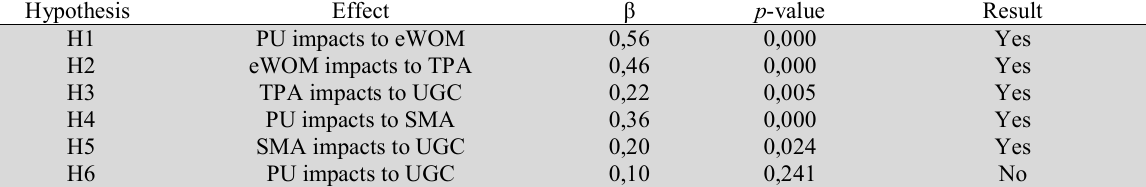
Results of hypotheses based on normalized regression Hypothesis